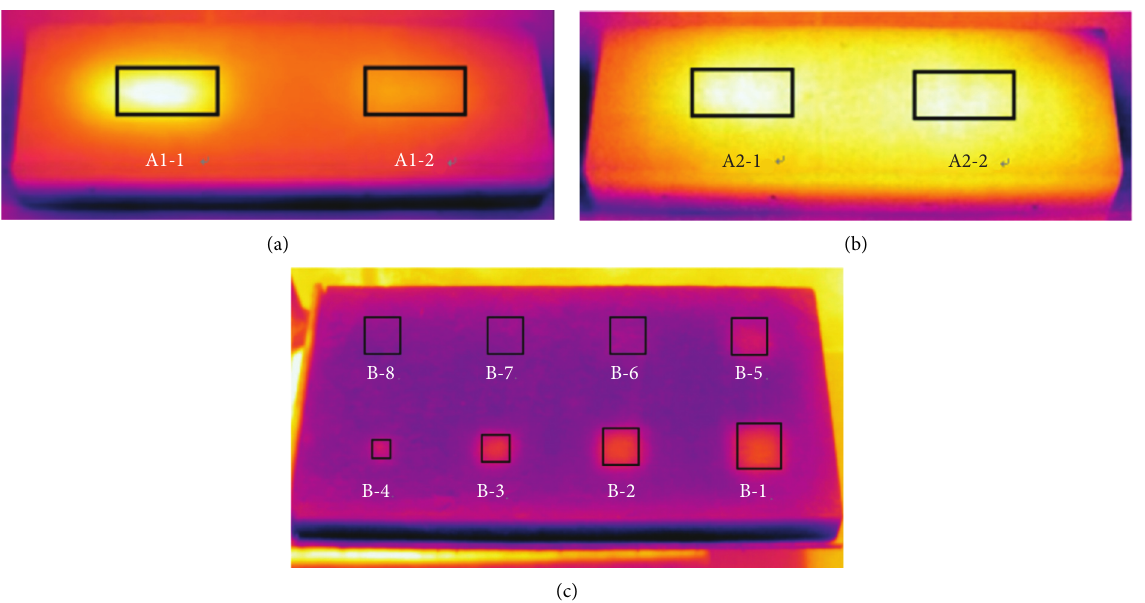
Figure 3: Temperature distribution. (a) A1-cool down for 12 minutes. (b) A2-cool down for 12 minutes. (c) B-heat up for 20